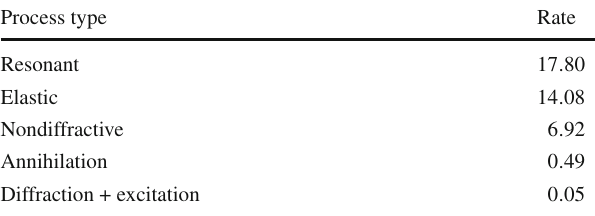
Table 10 Number of collisions of different types per 13 TeV non- diffractive pp event Process type